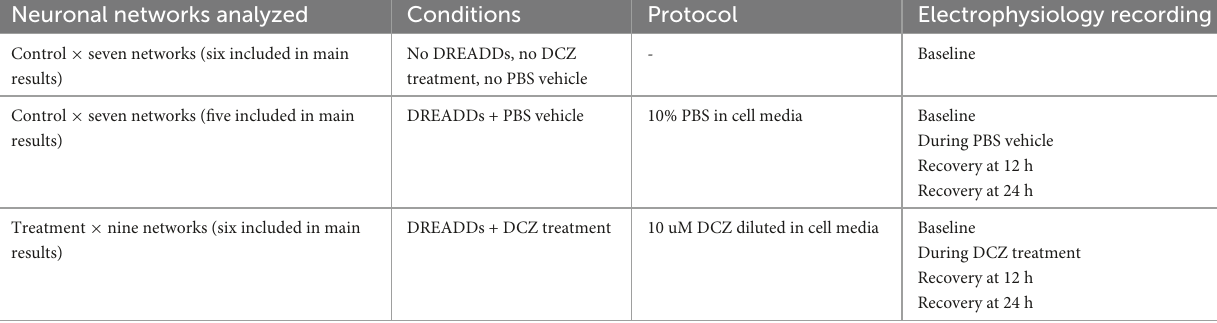
TABLE 2 Overview of networks analyzed, conditions, treatments received, and recordings done. Neuronal networks analyzed Conditions Protocol Electrophysiology